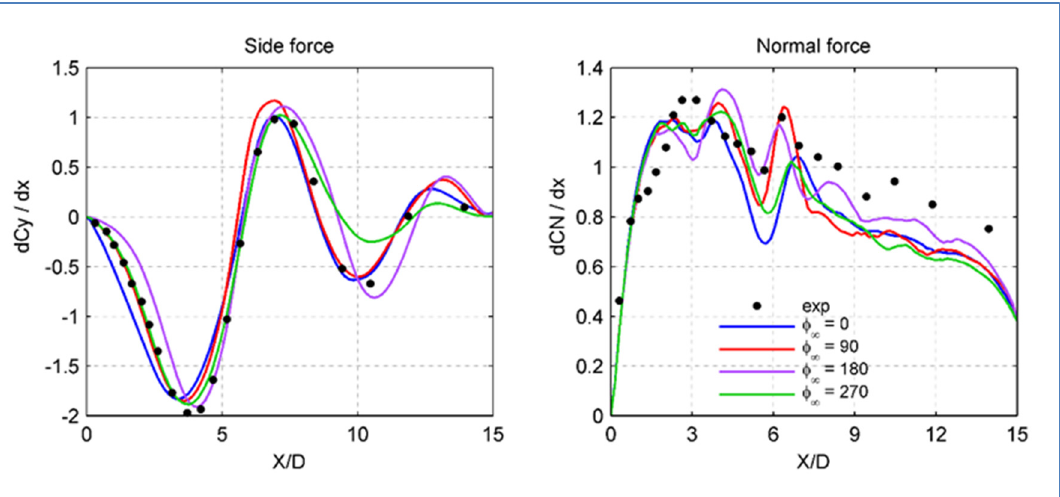
Figure 8. Averaged local force coefficients at different orientation angles at Ma = 0.2, Re = 2 × 10 6 and α = 45 degrees. Unstructured grid and experimental data.